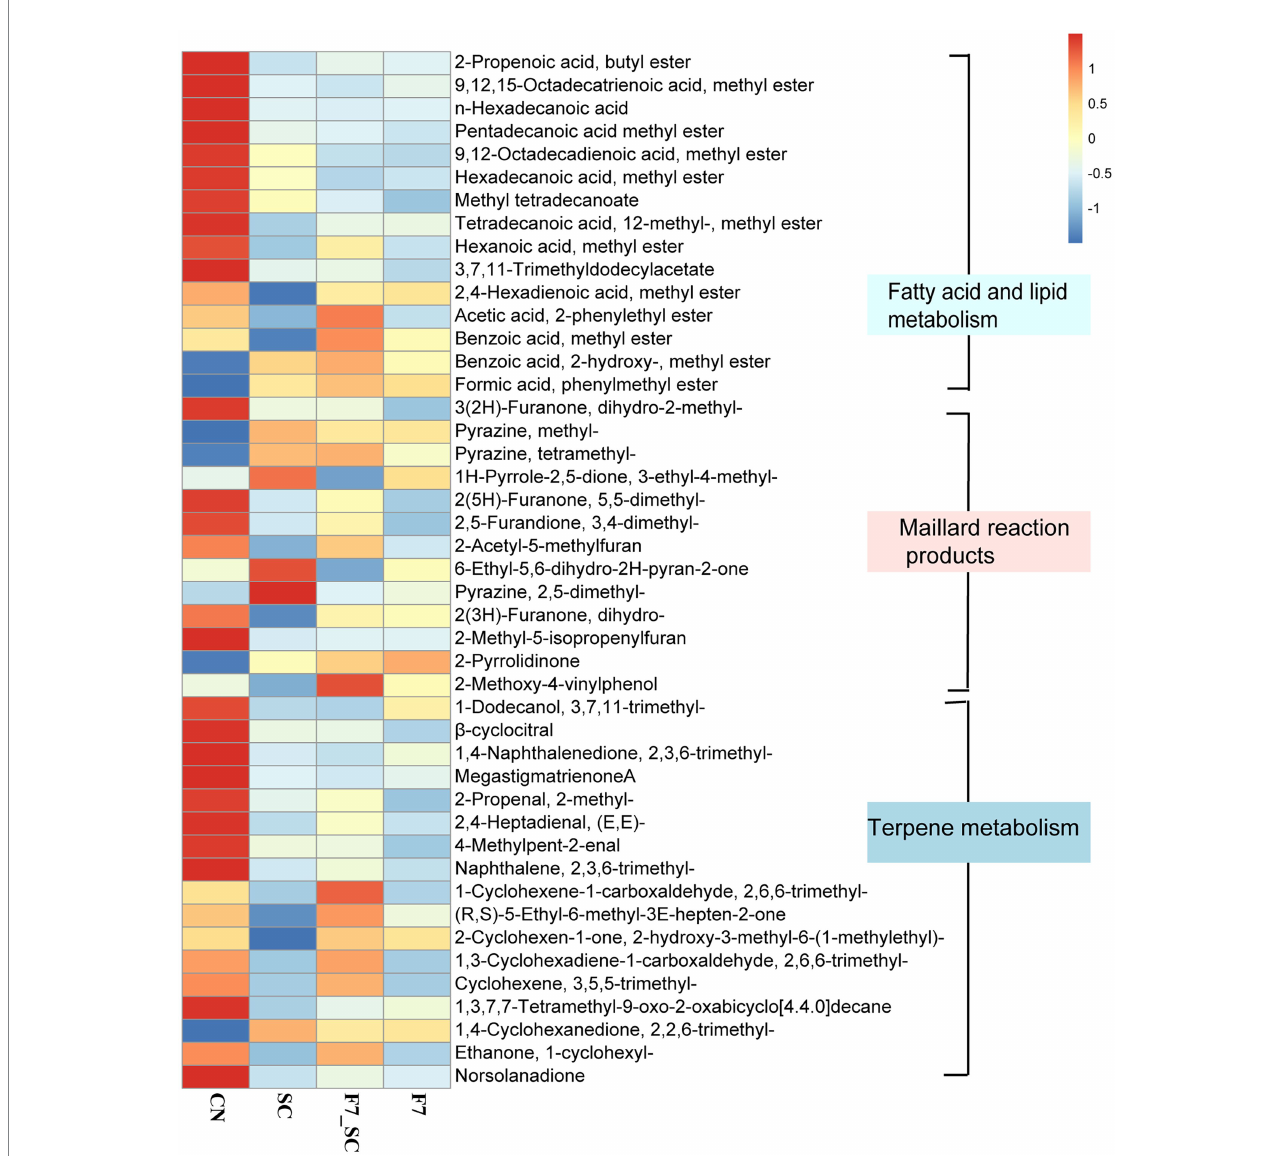
FIGURE 7 Heat map of key differential metabolites between control and bio-cultivation groups. CN represents the control group. SC represents B. kochii SC mono- culture. F7 represents F. magnum F7 mono-culture. F7-SC represents F. magnum F7- B. kochii SC